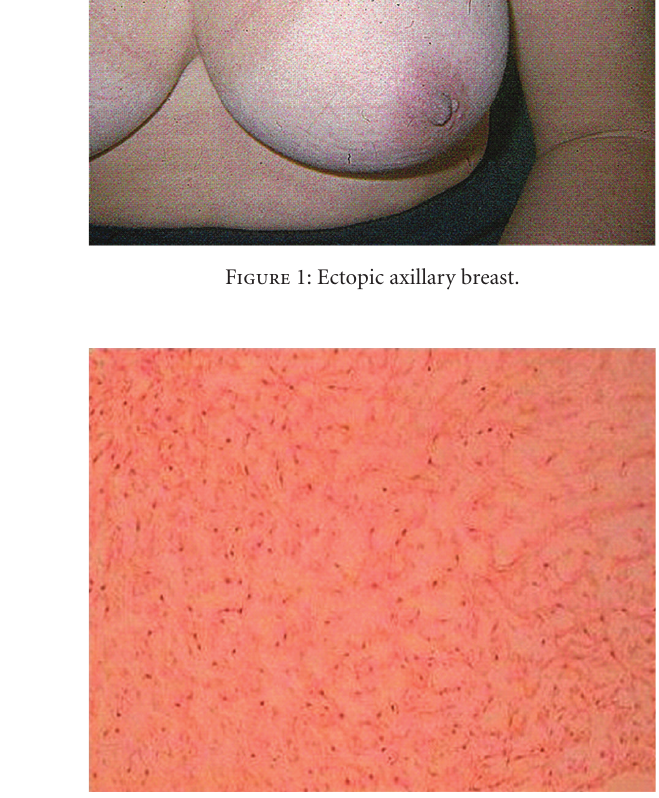
Figure 2: Histology: Breast